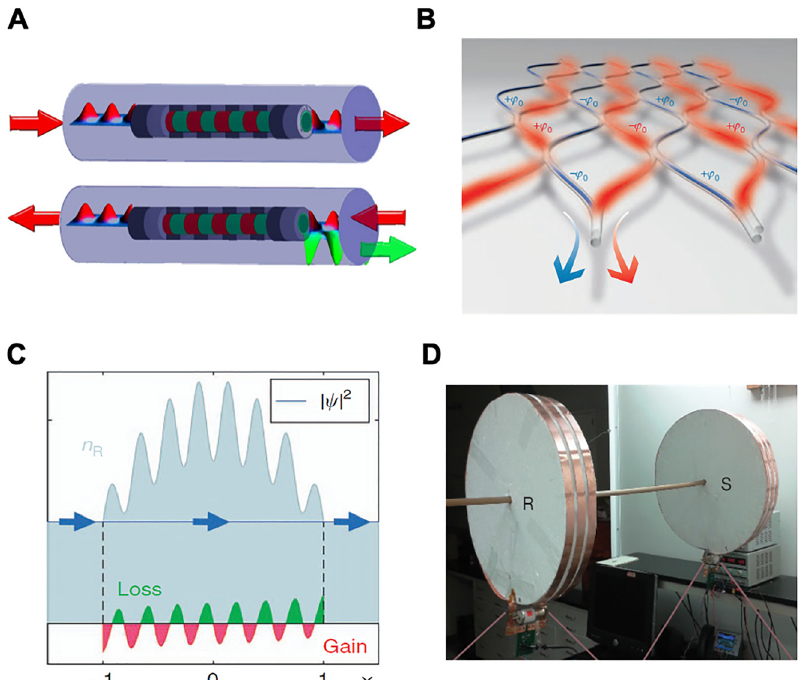
Figure 2: Unidirectional invisibility and parity-time